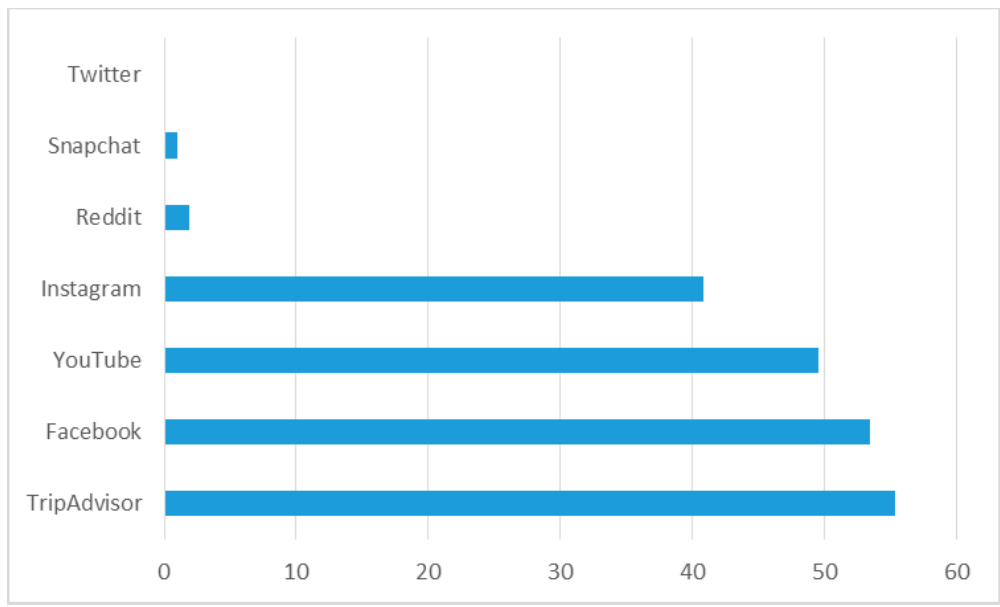
Figure 2. Media for obtaining information on tourist destinations by Generation Y [%]. Source: own work.